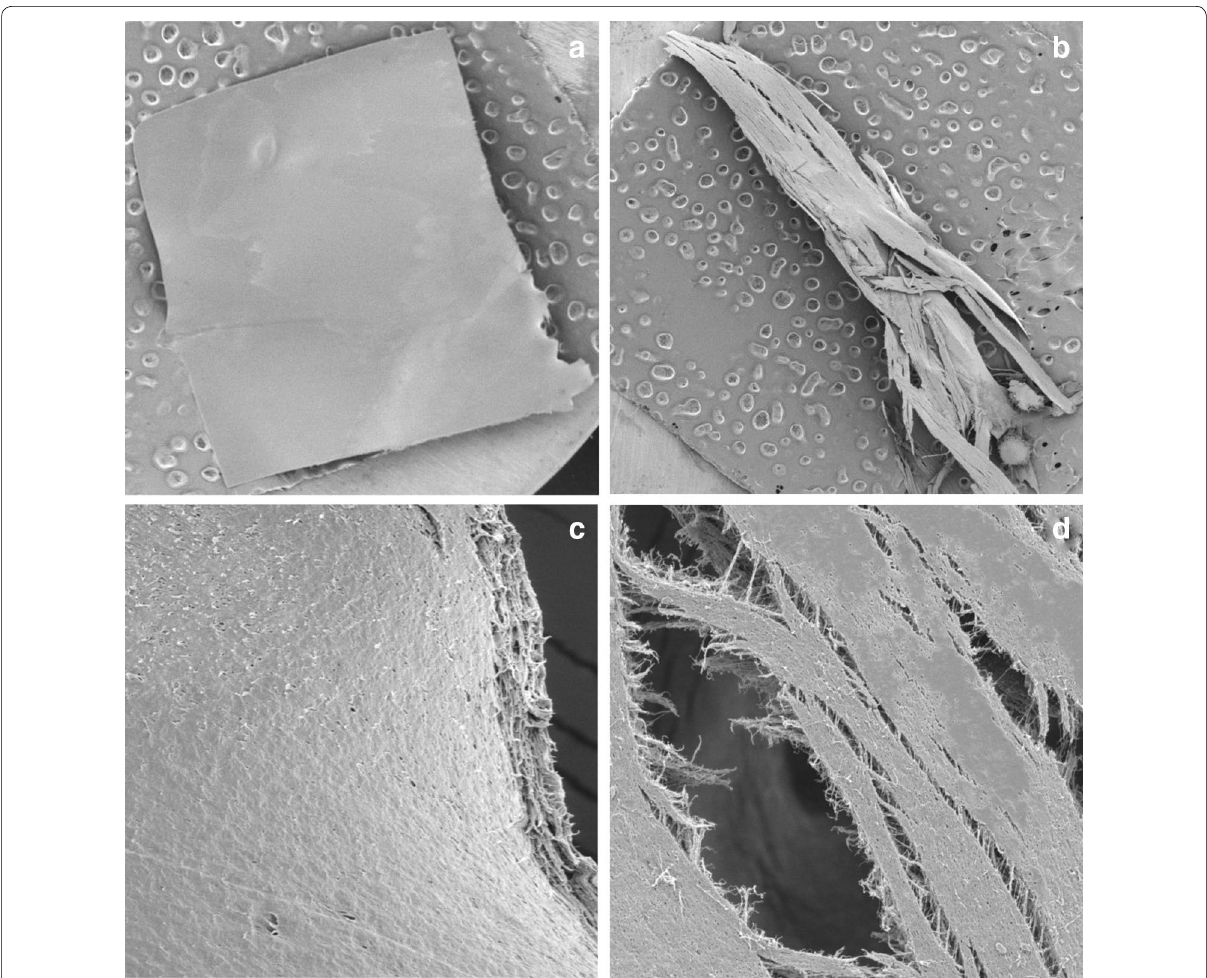
Fig. 6 Starch films at the end of cultivation at 20 °C by C. rosea 16G. The films were viewed by scanning electron microscopy at a 40 magnification ( a , b ) and at a 2000 magnification ( c , d ), as described in “Materials and Methods”. a , c The control; b , d C.